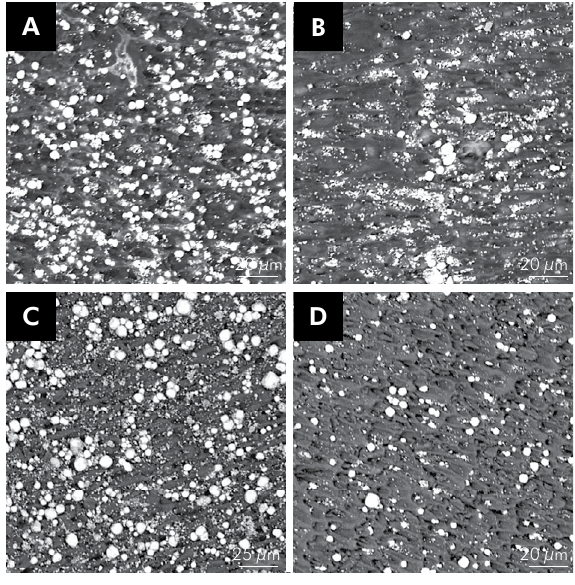
Figure 3. Representative image of residual persistence on dentin surface (A) G1 (E-I-AE), 95% ethanol and immediate acid etching; (B) G2 (X-I-AE), xylol and immediate acid etching; (C) G3 (E-D-AE), 95% ethanol and acid etching 7 days later; and (D) G4 (X-D-AE), xylol and acid etching 7 days later.